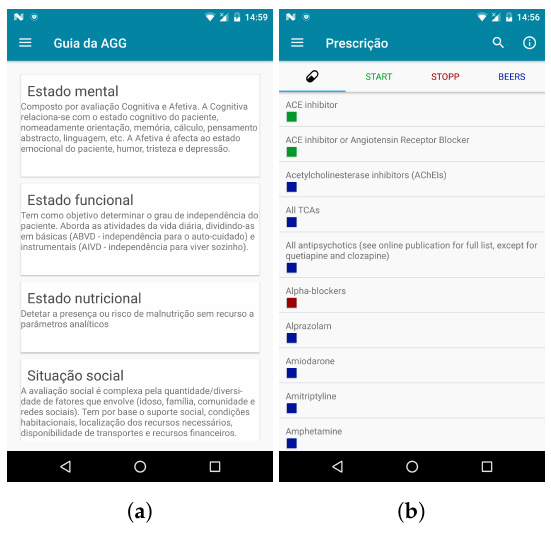
Figure 2. Screens for the second prototype of Geriatric Helper: ( a ) guides available regarding the different assessment dimensions (visible: cognitive, functional, nutritional and social); ( b ) clinical criteria to observe when prescribing for elderly